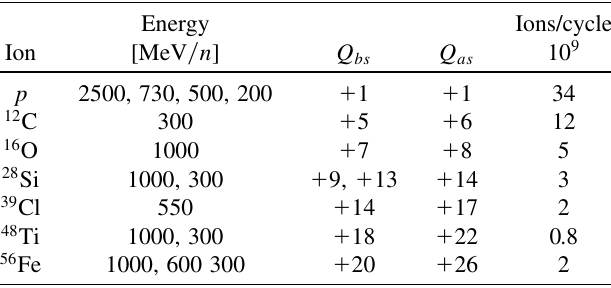
TABLE I. Ion species and energies of the ions, which have been transported via the NSRL beam-transport line since the start of NSRL operations. The labels Q states of the ions before and after the stripping foil (see text).